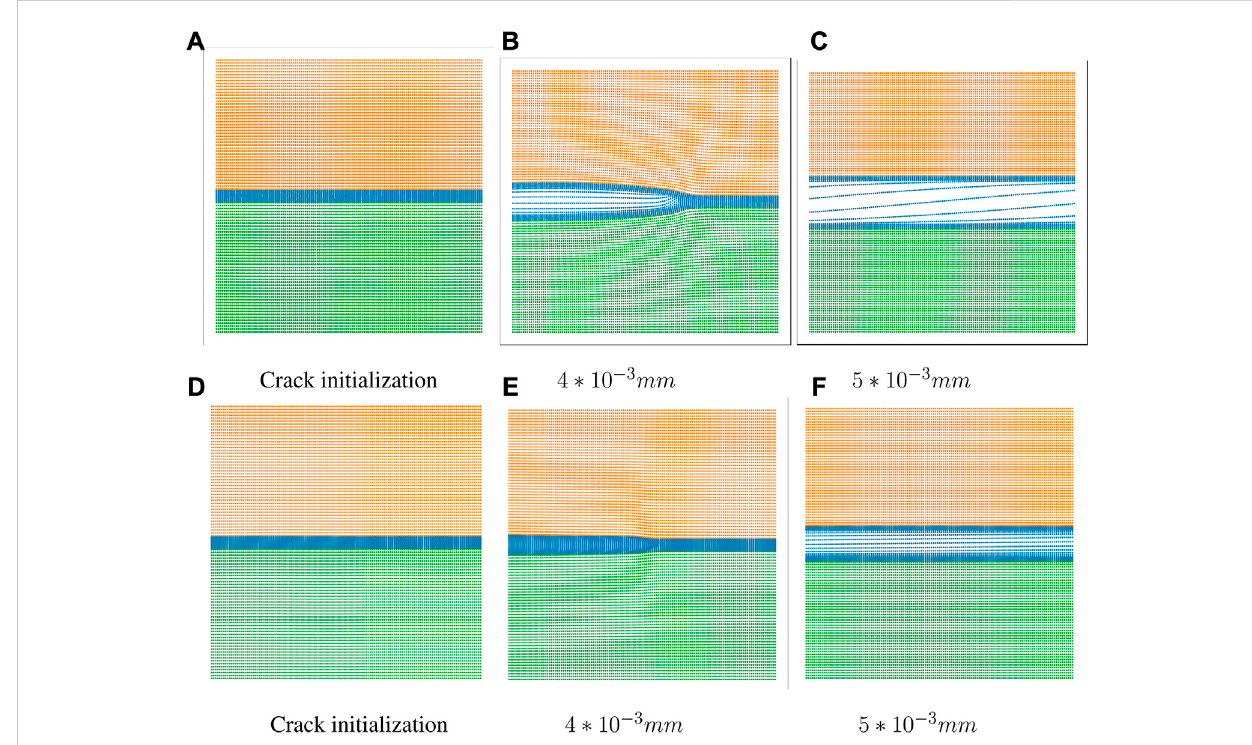
FIGURE 9 Scatterplotsofsingle-sidednotchedplateswith4and10timesofmodelenlargementwhilemaintainingthepeakstressunchanged.Theupperhalf: